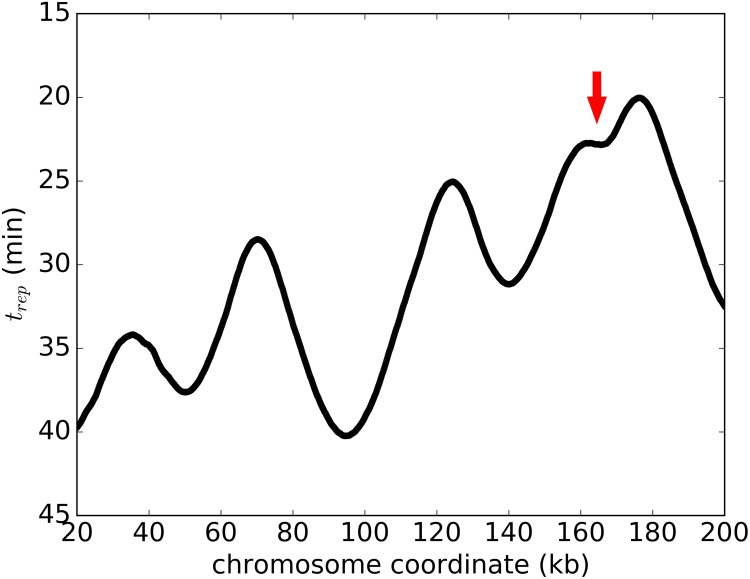
Replication profile derived from our best model: Stochastic forks’ speed not depending on genomic location and stochastic origin firing (σt ≠ 0).Note that the replication profile slope is highly variable (as indicated by the red arrow) even though the fork speed is constant. Here, the variation in slope is due to the origin firing with different probabilities at different times, although such variation can be also caused by local variability of forks’ speeds.